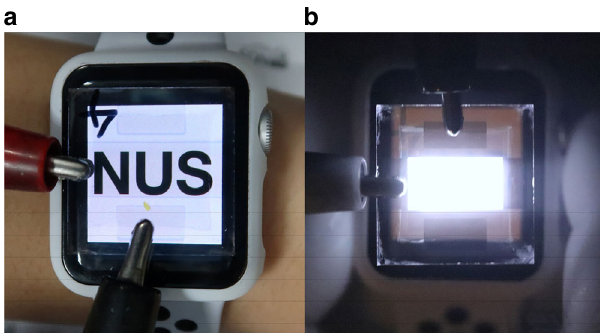
Fig. 3 Demonstration of covert illumination function of a transparent perovskite light-emitting diode. a A transparent PeLED overlaid across a smart-watch display to show high optical transparency and neutral color. b Near-infrared photo showing bright NIR electroluminescence from the transparent PeLED above the smart-watch